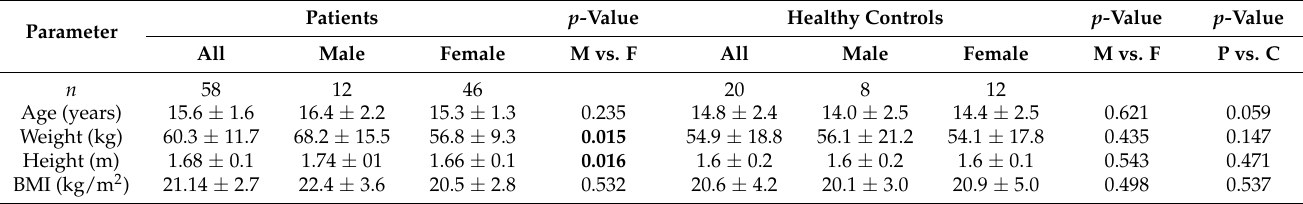
Table 1. Baseline characteristics of depressed patients and healthy controls.